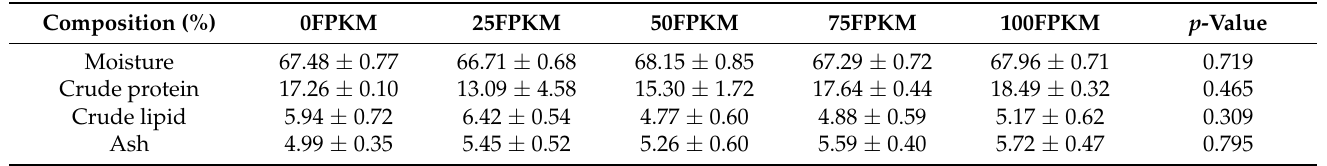
Table 6. Whole body composition (% of wet weight basis) of sex-reversed red tilapia fed with experimental diets containing varying levels of FPKM for 12 weeks.